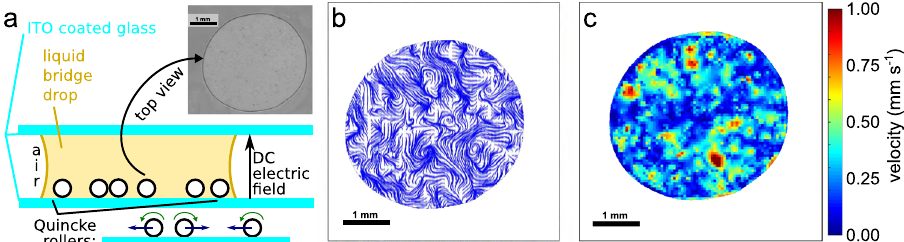
Fig. 1 Quincke rollers in a droplet. a A sketch of the experimental system: A small amount of weakly conductive liquid (hexadecane) surrounded by air forms a bridge between two planar electrodes. Inside of the quasi-two-dimensional drop are polystyrene spheres that start to roll upon application of a uniform DC electric fi eld, E . Quincke rollers initially move in random directions along the surface of the bottom electrode. Blue and green arrows indicate the direction of translation and rotation of the rollers, respectively. The image shows the top view of the drop and enclosed rollers. b The monolayer of rolling particles generates an essentially two dimensional fl ow. Streamlines reveal the formation of transient vortices throughout the droplet. c Snapshot of the velocity fi eld inside the droplet as determined by particle image velocimetry (PIV). Experimental parameters: packing fraction of the Quincke rollers φ = 0.58± 0.11, droplet area is A